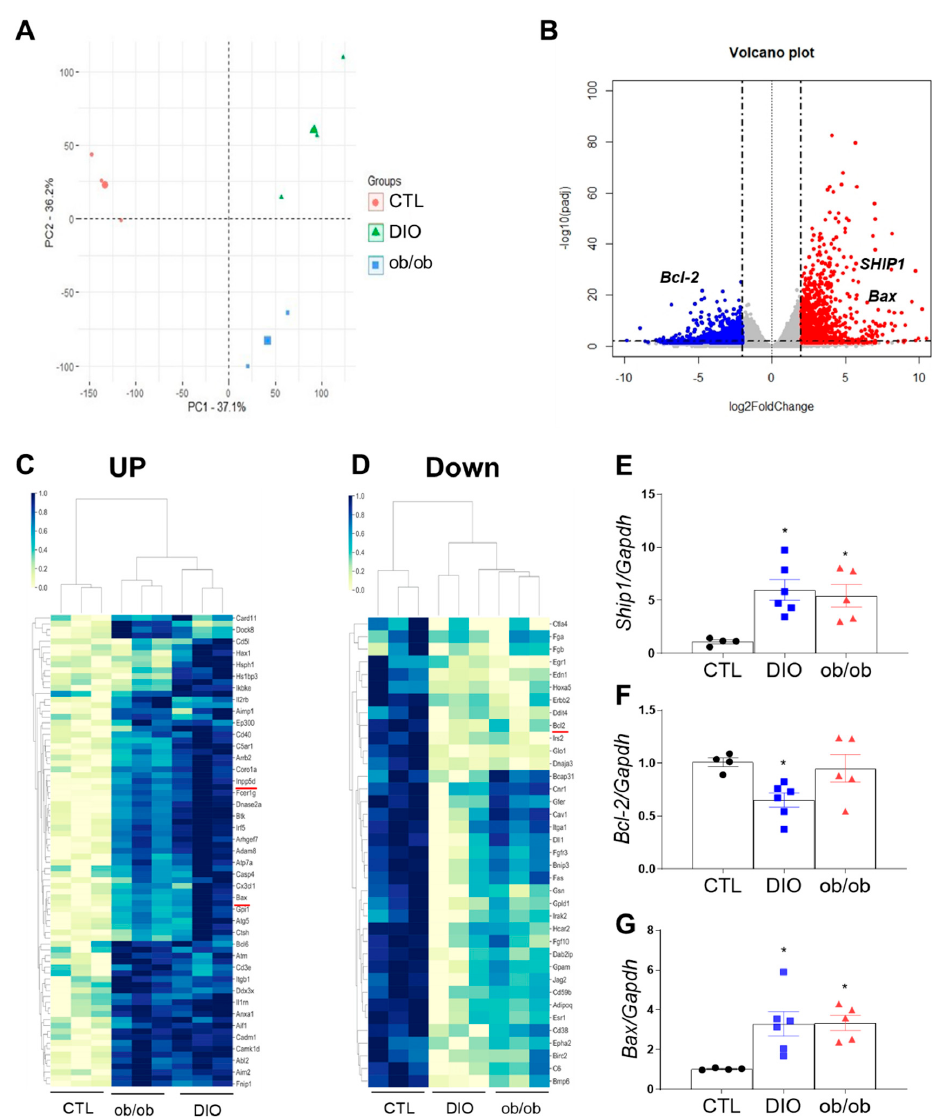
Figure 2. RNA-seq analysis of adipose tissue. ( A ) Principal component analysis for 9 samples from CTL, DIO, and ob/ob mice (3 replicates for each group). ( B ) Volcano plot shows the differential gene expressions as blue and red dots (|fold change| < 1.60). ( C ), ( D ) Cluster map of differential gene expression related to immune system and apoptosis showing upregulated ( C ) and downregulated genes ( D ) in CTL mice relative to DIO or ob/ob mice. ( E ), ( F ), ( G ) Quantitative RT-PCR analysis of Src homology domain-containing inositol 5 ′ -phosphatase 1 (Ship1) ( E ), Bcl-2 ( F ), and Bax ( G ). Data are presented as the means ± SEM; * p < 0.05 versus CTL mice; † p < 0.05 versus DIO mice. CTL (black circle), DIO (blue square), ob/ob (red triangle).